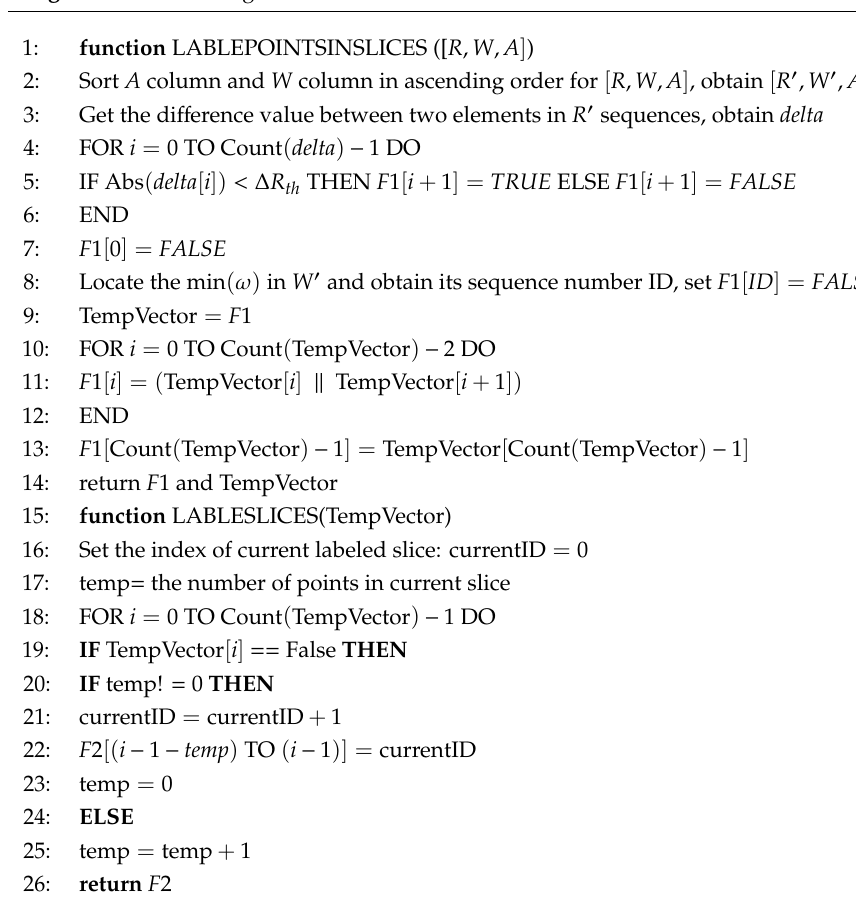
Algorithm 1 Extracting Valid